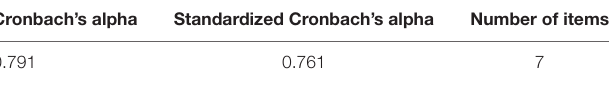
TABLE 1 | Reliability statistics.